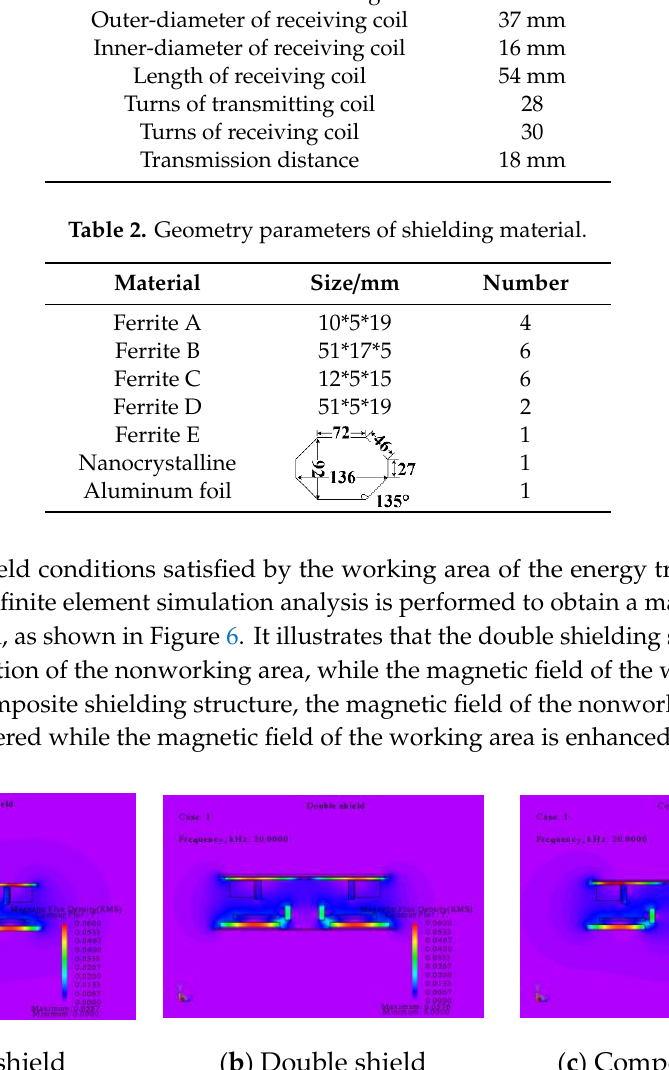
Table 2. Geometry parameters of shielding material.